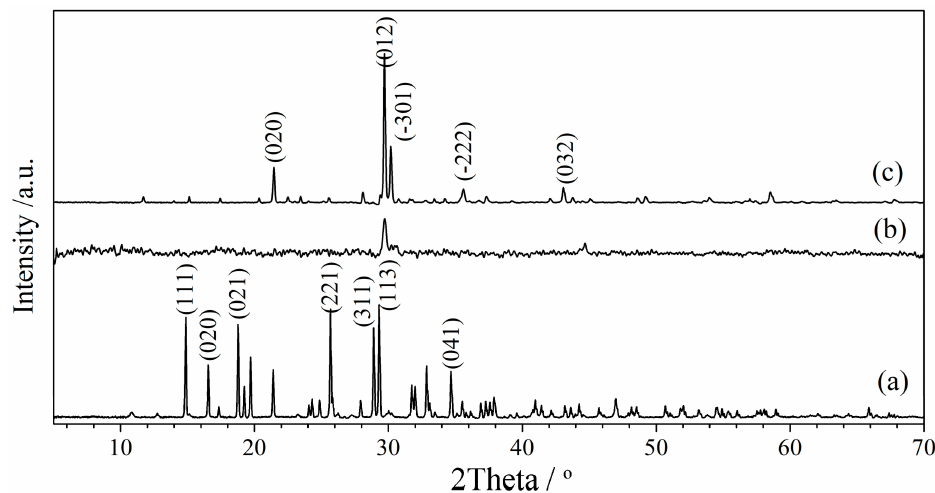
Figure 3. XRD patterns: ( a ) MgHPO 4 · 3H 2 O, ( b ) the calcined products at 773 K, and ( c ) the calcined products at 973 K (4 h in air